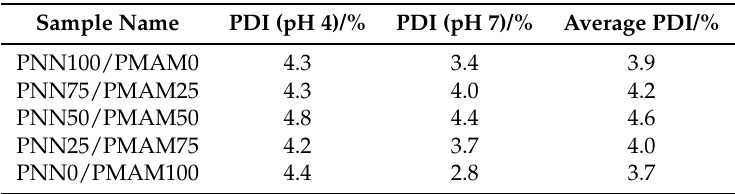
Table 3. Polydispersity index (PDI)-values of all core-shell microgels in the swollen state, obtained from the cumulant analysis of the angle-dependent PCS measurements at 10 ◦